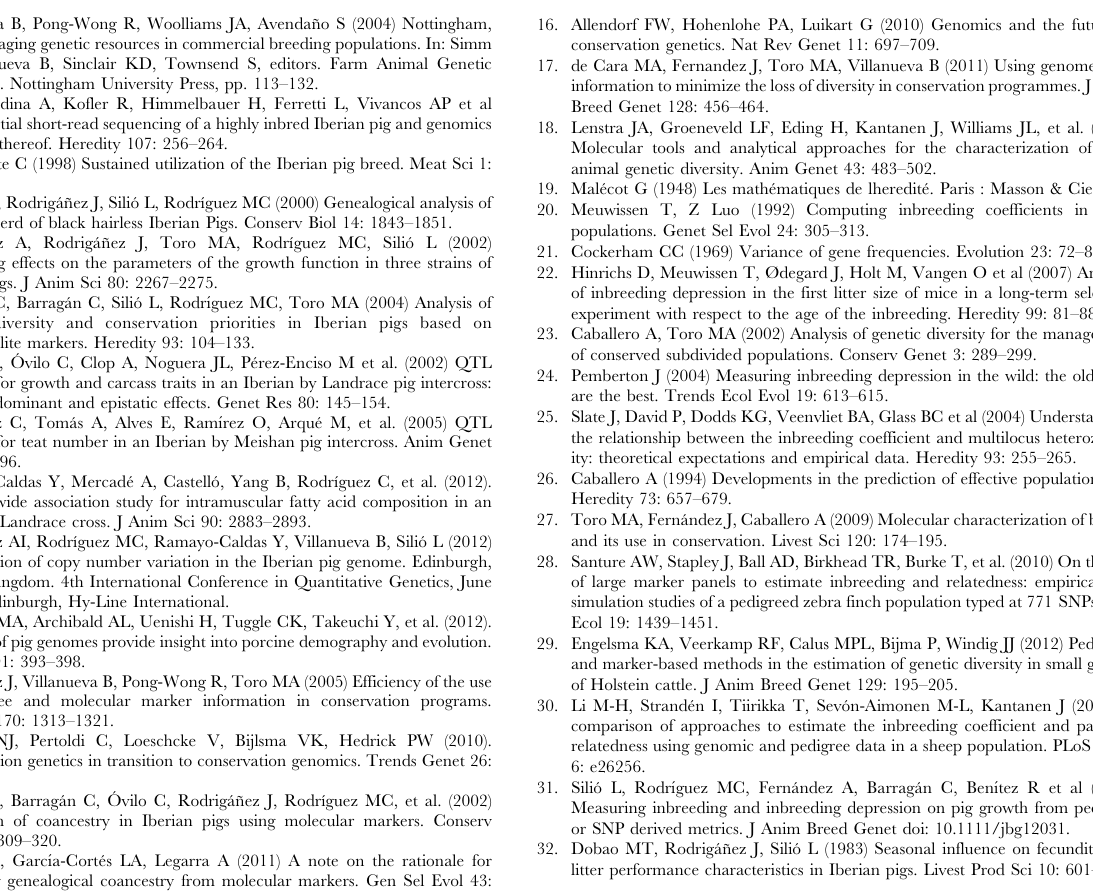
Table S1 Quality control criteria, thresholds used to filter genotypic data, and number of SNPs discarded. Table S2 Summary statistics for the 56 microsatellite loci typed for 30 Guadyerbas